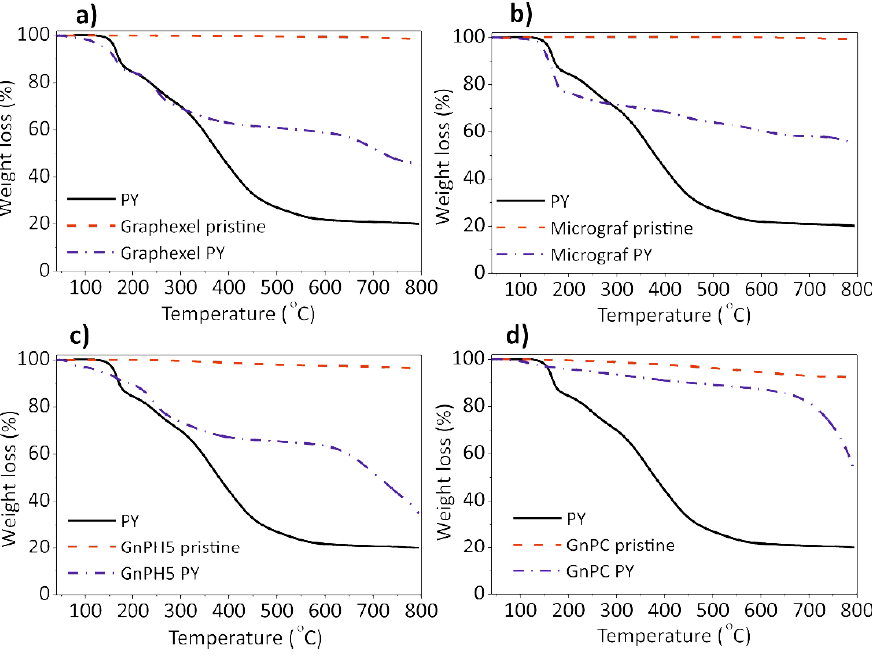
Figure 4. Thermogravimetric analysis (TGA) curves of the graphite starting material and exfoliated graphite: ( a ) Graphexel; ( b ) Micrograf; ( c ) GnPH5; and ( d ) GnPC. graphite: ( a ) Graphexel; ( b ) Micrograf; ( c ) GnPH5; and ( d )